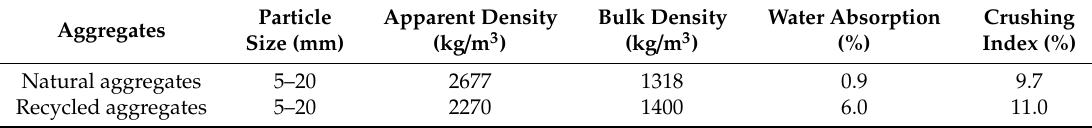
Table 2. The properties of natural coarse aggregates and recycled coarse